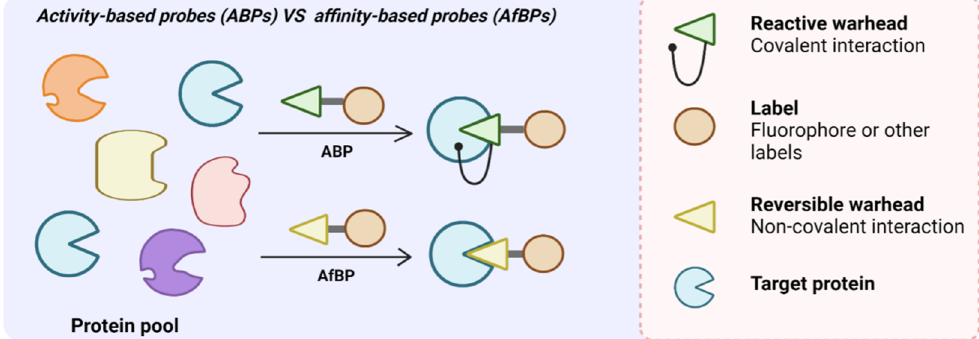
Figure 1. Schematic diagram of activity-based probes and affinity-based probes binding to the target protein.